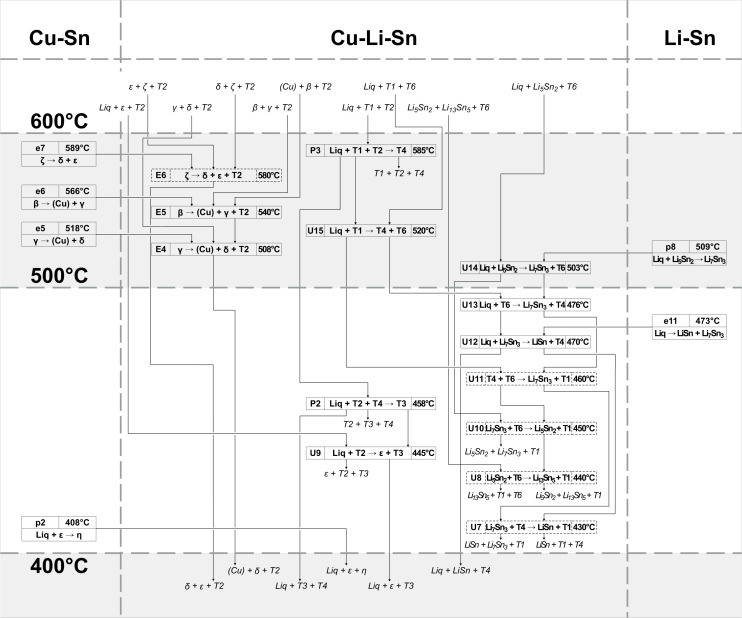
Reaction scheme T = 400–600°C.